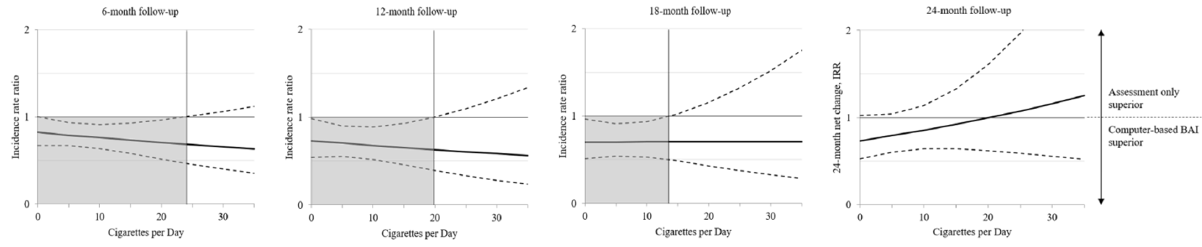
Figure 3. Plot of regions of significance for the effects of the computer-based BAI compared to assessment only.